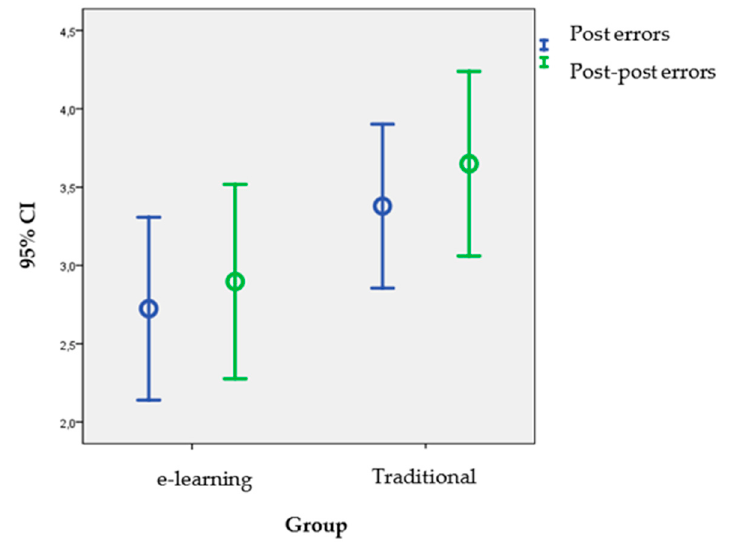
Figure 4. Inadequate technical means and confidence intervals (95%).